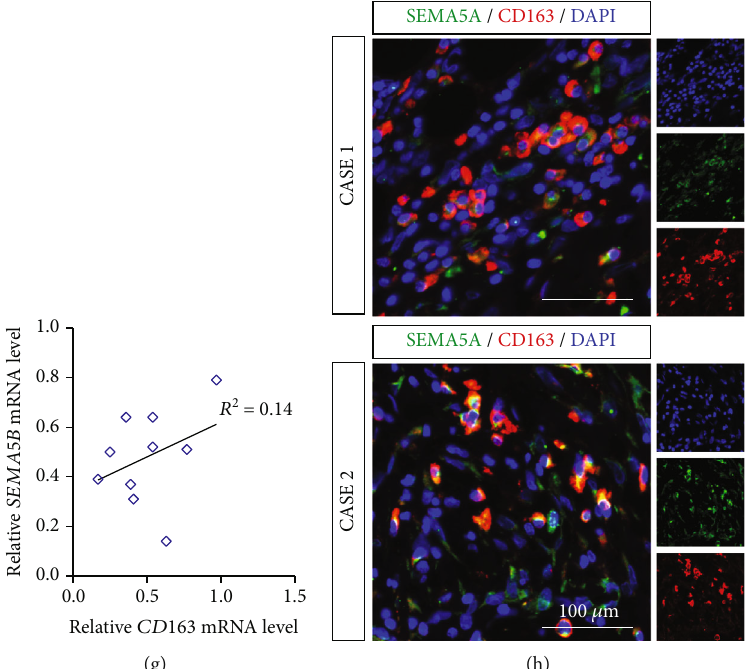
Figure 1: SEMA5A is secreted from M2 macrophages in PDAC liver metastatic niches. (a) Abundance and distribution of in fi ltrated TAMs in liver metastasis of PDAC were measured by IHC-P staining on M1 macrophage markers (CD163 and IBA1) or M2 macrophage markers (MHCII and CD11c) ( n = 20 patients, 3 fi elds assessed per sample). Scale bars, 100 μ m. (b) The SUV di ff erence between patients bearing TAMs slightly in fi ltrated metastatic niches ( n = 8 ) and TAMs severely in fi ltrated ones ( n = 12 ). Mean ± s : e : m : ; two tailed unpaired t -test, ∗∗ P < 0 : 01 . (c) The Kaplan-Meier analysis on patients bearing TAMs slightly in fi ltrated metastatic niches ( n = 8 ) and TAMs severely in fi ltrated ones ( n = 12 ) was performed. (d) Real-time PCR measured expressions of secreted semaphorin family in TAMs slightly or severely in fi ltrated metastatic niches ( n = 5 samples per group). (e) IHC-P staining on SEMA5A demonstrating its distribution in liver metastatic niches of PDAC ( n = 20 patients, 3 fi elds assessed per sample). Scale bars, 100 μ m. (f, g) The relationship of CD163 expression and SEMA5A (f) or SEMA5B (g) was measured ( n = 10 samples). (h) IF staining on SEMA5A and CD163 in PDAC liver metastatic niches displaying their colocation situations ( n = 20 patients, 3 fi elds assessed per sample). SEMA5A, green; CD163, red; DAPI, blue; scale bars, 100 μ